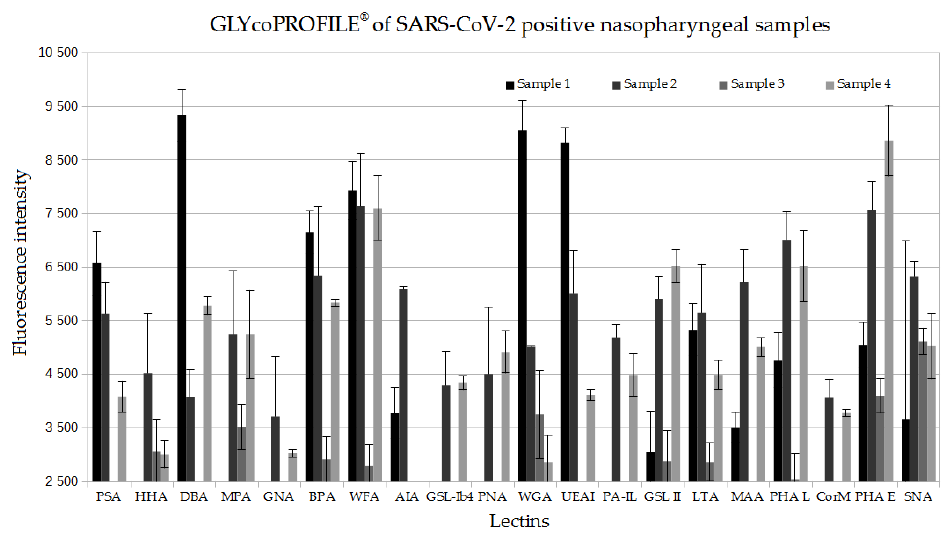
Figure 2. GLYcoPROFILE ® raw data of 4 SARS-CoV-2-positive nasopharyngeal samples on a panel of 20 lectins. Non-diluted samples were screened against selected lectins, previously adsorbed on LEctPROFILE ® plate, and revealed with anti-SARS-CoV-2 antibodies (1/100). Then, using these 10 selected lectins, the GLYcoPROFILE ® study (Figure 3) was ex- tended to a larger panel including 45 participants of whom 39 tested positive for SARS- CoV-2 and 6 were negative(both positive and negative tests were confirmed by antigenic testing). Among the positive group of samples, based on the fluorescence intensity data represented in the histogram, the higher interaction is apparent on all screened lectins except HHA lectin, which shows visibly lower interactions. The six negative samples gen- erally showed low interactions with all the lectins, with a fluorescence intensities thresh- old value of around 1000. Through the interpretation of the GLYcoPROFILE ® raw data in Figure 3, the lectin HHA can be highlighted as a negative reference lectin for evaluation of SARS-CoV-2-positive samples, whilst for the rest of the lectins, the intensity interac- tions are ambiguous, and interpreted in this graphical representation.